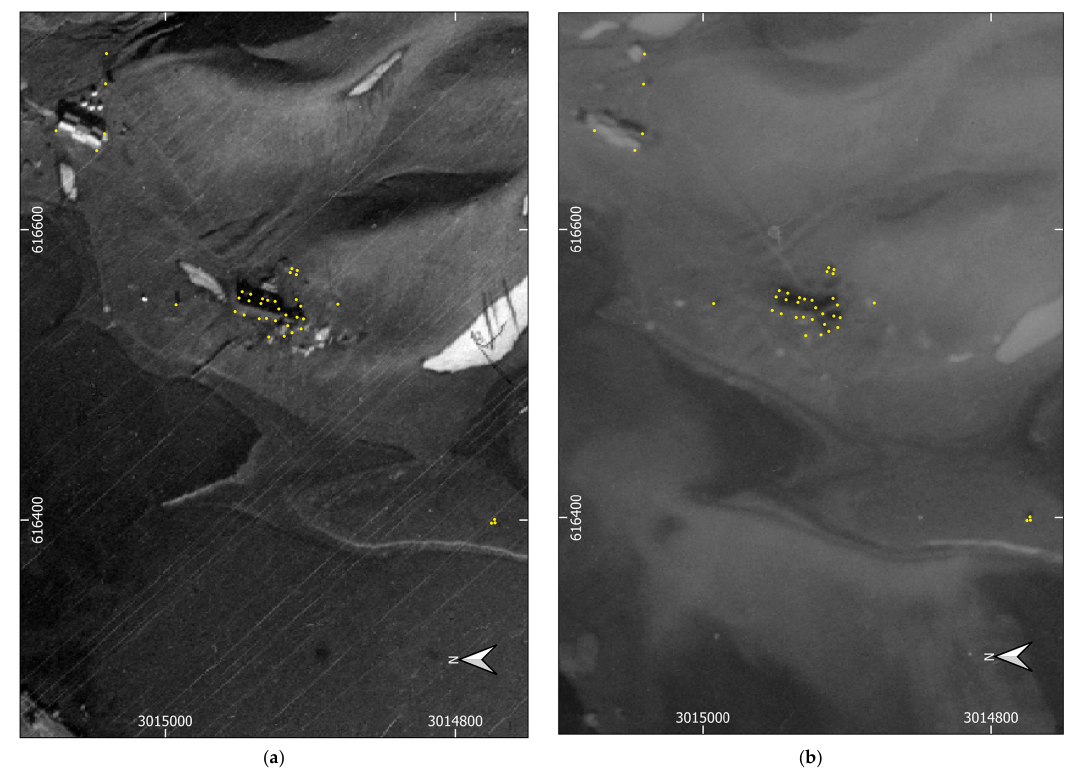
Figure 6. Argentinean base in 1956 ( a ) and 1968 ( b ). Ground control points are coloured yellow, coinciding with the corresponding features, in WGS84–UTM20S.